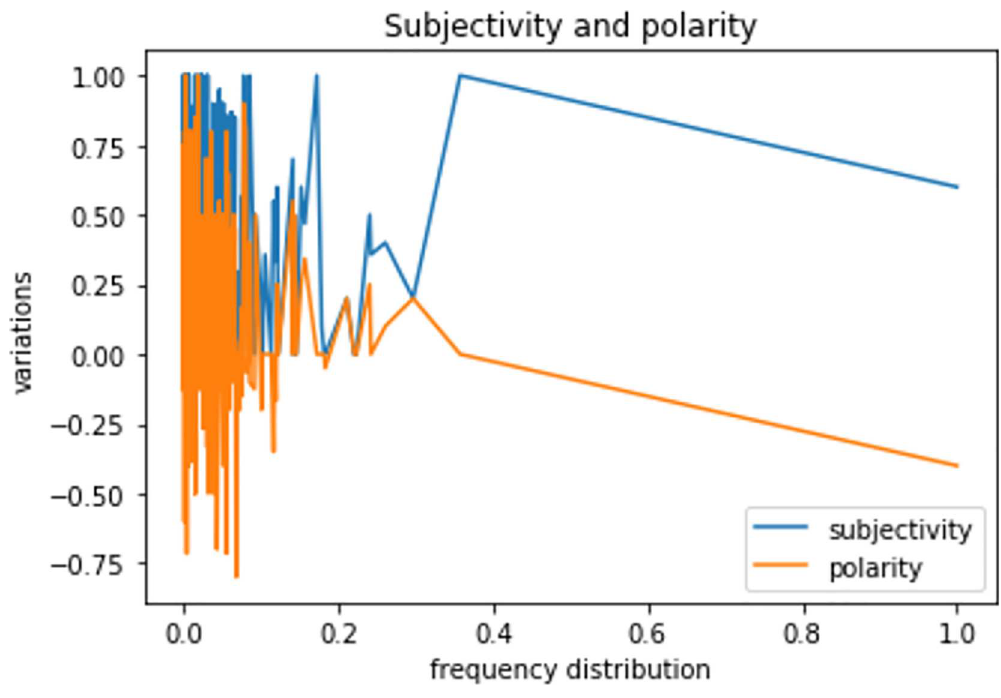
Fig 19. Terms frequency and polarity/subjectivity.